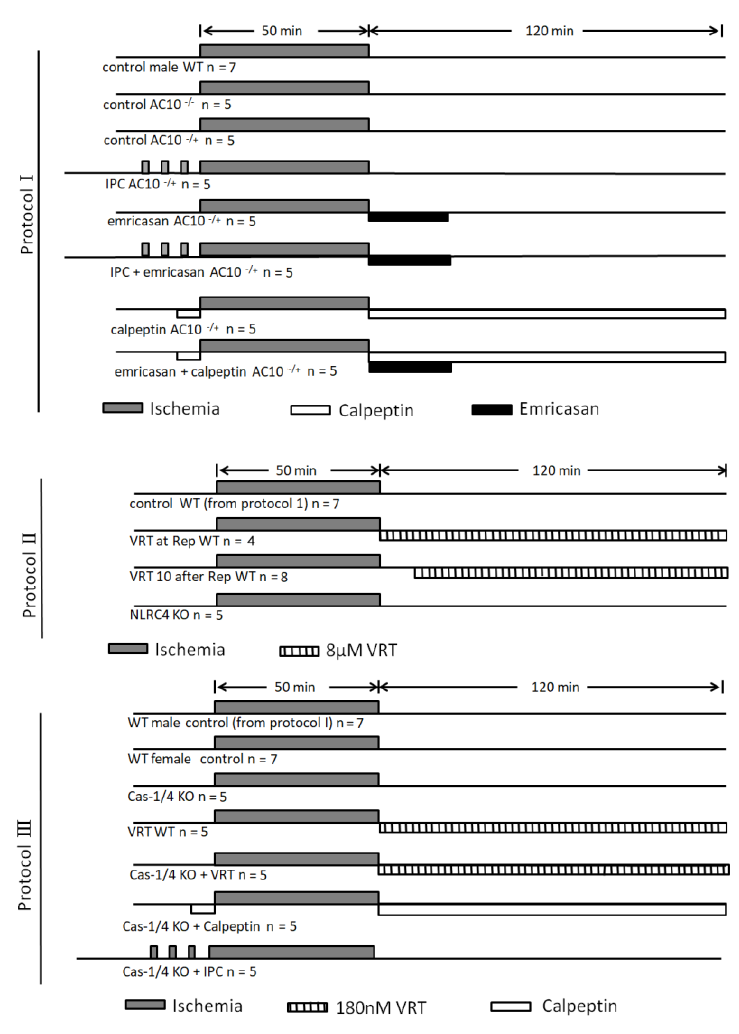
Figure 5. Diagram of the three protocols used in the study. The fourth cohort in protocol I was ischemically preconditioned with three cycles of 5 min of no perfusion/5 min of reperfusion prior to the index ischemia. The fifth cohort was treated with the pan-caspase inhibitor emricasan (8 µ M) for the first 20 min of reperfusion. In a monocyte cell assay, apoptosis-related caspases were inhibited with an EC 50 of 0.27 µ M [38]. An irreversible inhibitor has two determinants of its potency: